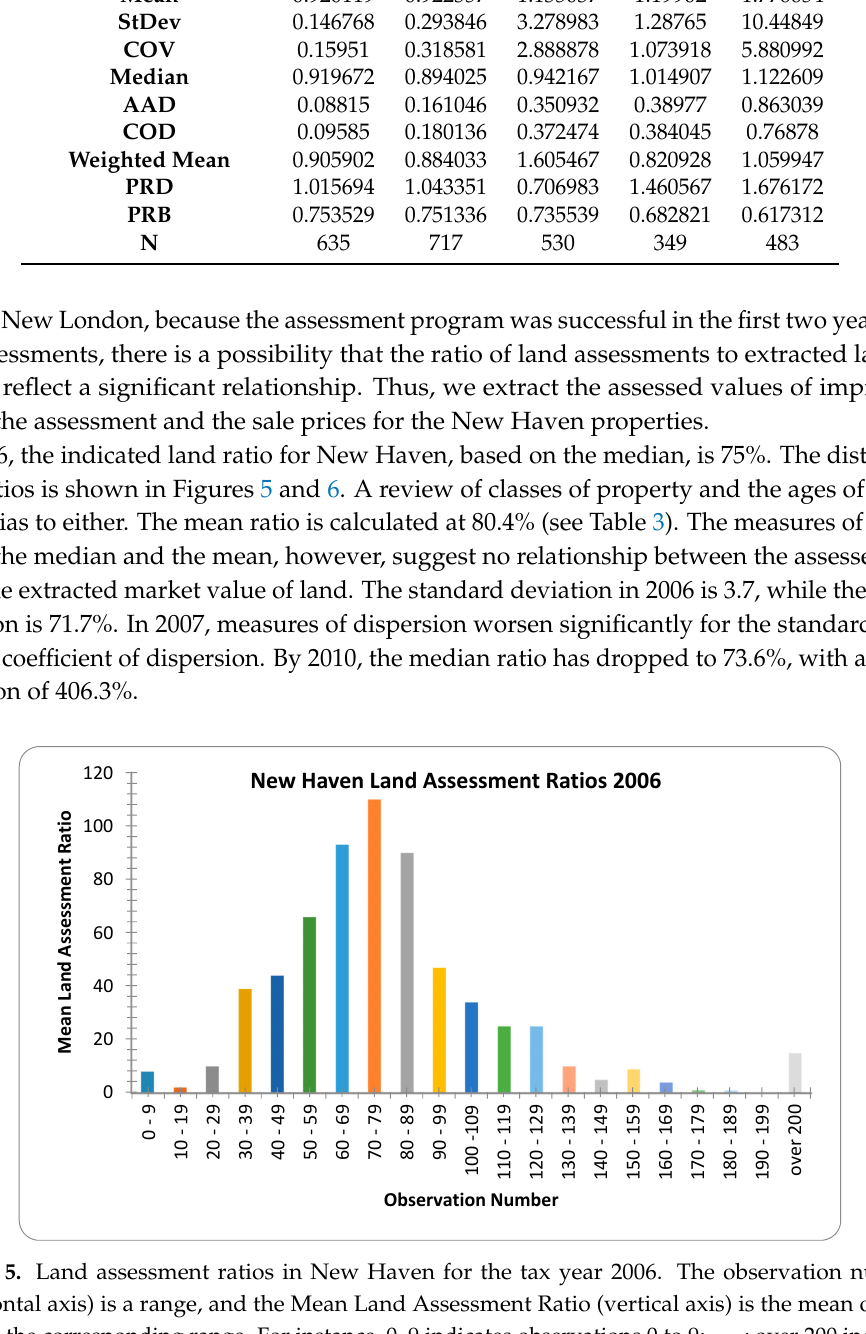
Table 2. Overall ratio descriptive statistics for all qualified sales in New Haven.